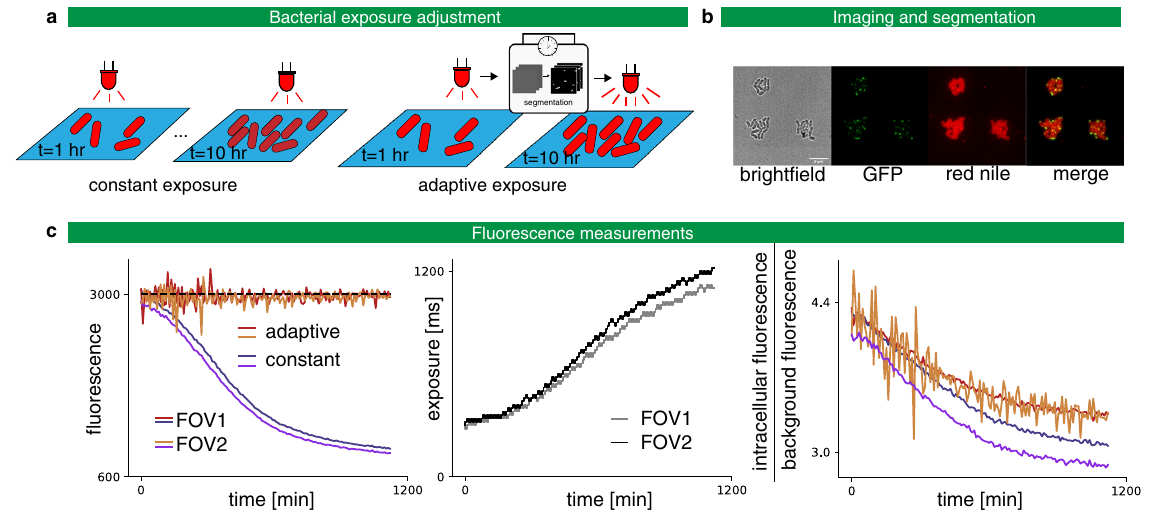
Fig. 2 Adaptive exposure preserves imaging quality. a Left: Classic constant exposure experiment, in which the same amount of light is sent throughout the experiment. Right: adaptive experiment, in which bacteria are segmented after each frame and the exposure is increased or decreased depending on the measured fl uorescence. b Imaging C. glutamicum in bright fi eld and fl uorescence with Wag31 fused to mNeonGreen and localized to the poles (GFP), and with red nile stain. c Left: In the constant exposure experiment, the fl uorescence decays. For the adaptive experiment, fl uorescence tracks the target value of 3000 arb. units. The experiment is performed in two fi elds of view (FOV) in parallel. Center: The exposure settings as a function of experiment time. Right: Signal-to-noise ratio as de fi ned by the intracellular fl uorescence divided by the background fl uorescence as a function of the experiment time. A less severe degradation is obtained with the adaptative